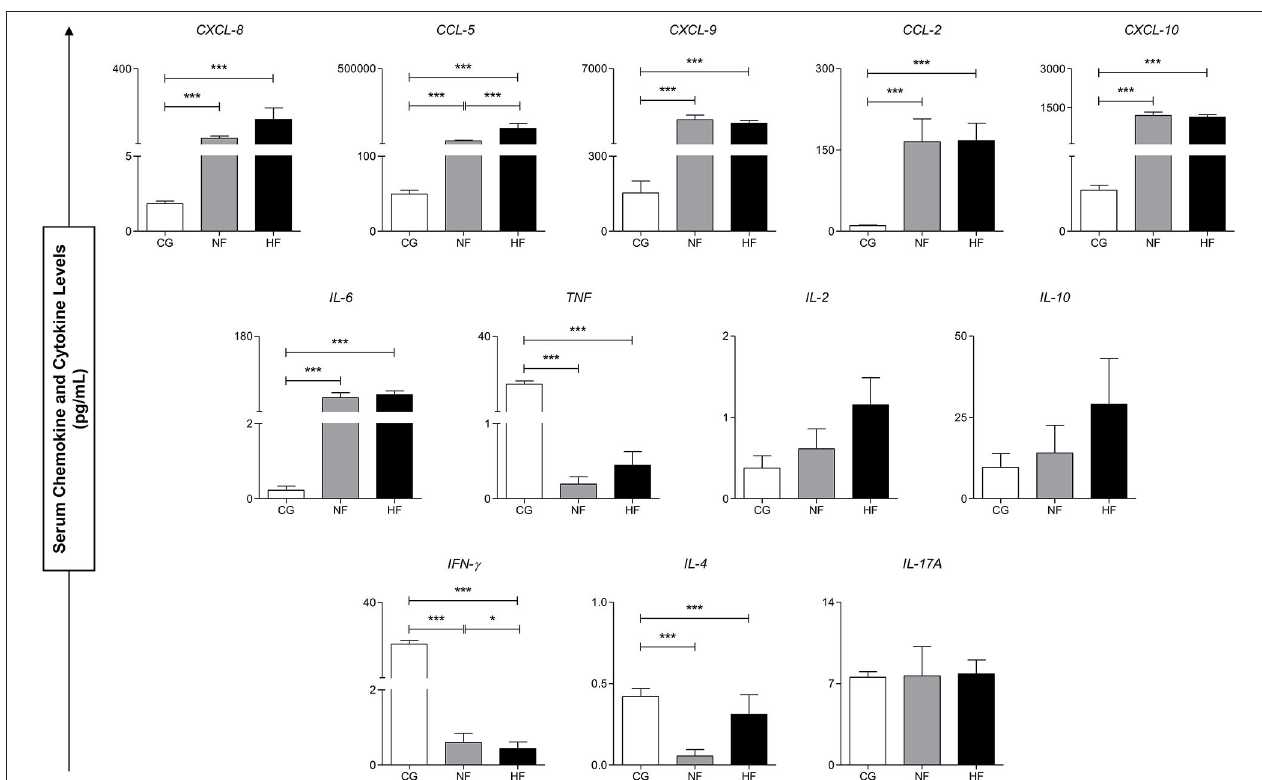
FIGURE 2 | Serum concentrations of circulating molecules of control groups (CG), normal fibrinogen (NF) and hypofibrinogenemia (HF) at T0. * p < 0.05; *** p < 0.0001.